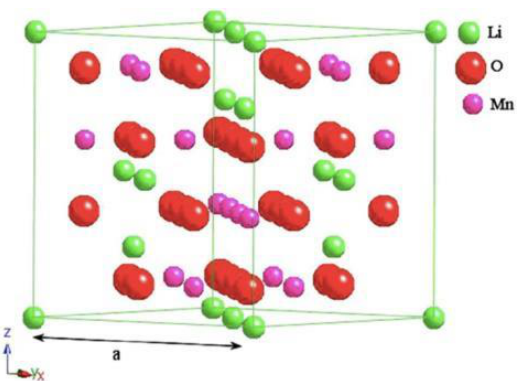
Figure 2. The crystal structure of spinel LiMn 2 O 4 (reprinted from Ref. [40] with permission from Elsevier).